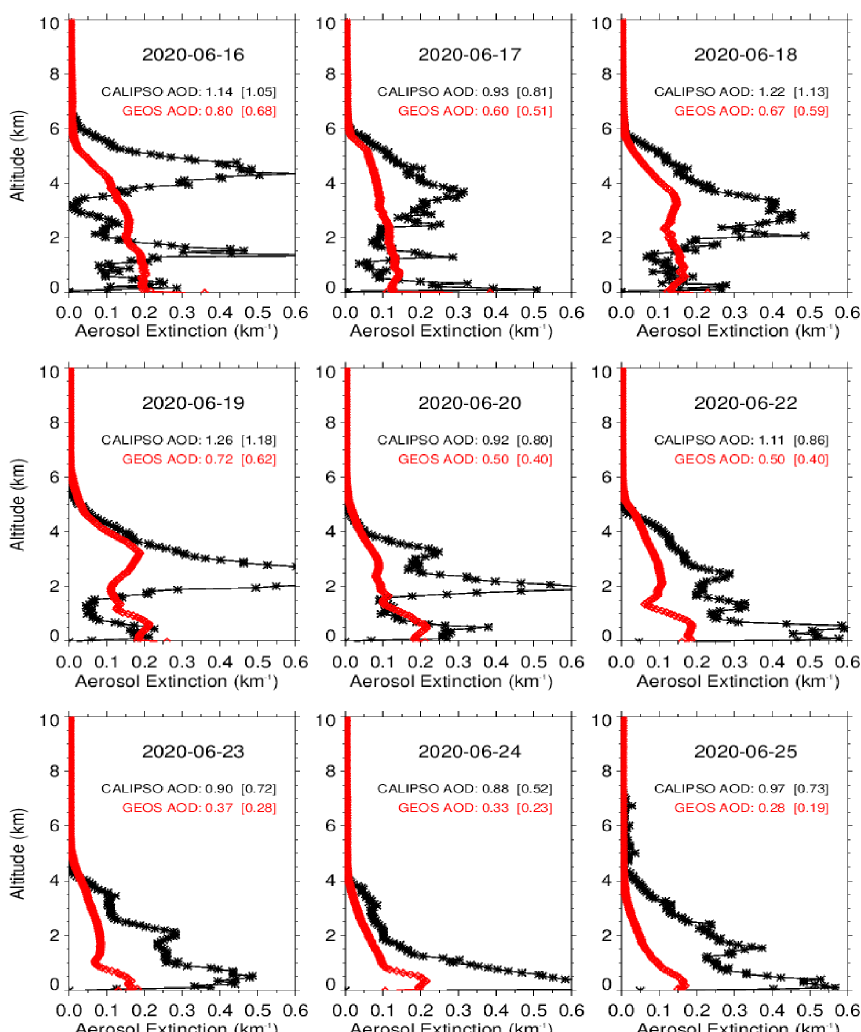
Figure 18. Latitude-averaged (5–30 ◦ N) aerosol extinction (km − 1 ) profiles from CALIOP (black) and GEOS (red) (corresponding to CALIPSO tracks illustrated in Fig. 17), showing the evolution of vertical structure of the dust plume in the course of trans-Atlantic transport from the coast of North Africa (16 June) to the Gulf of Mexico (25 June). CALIOP AOD and GEOS AOD are also denoted in the plots (numbers in parentheses are AOD above the 500m altitude). GEOS model outputs were excluded in the averaging when CALIOP detected clouds or the laser was totally attenuated (marked as light gray and black in Fig. 17,